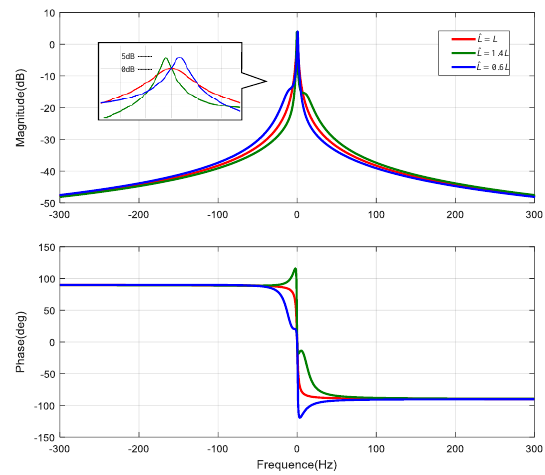
Figure 5. Complex vector FRF for variations in ˆ L of the inverter with a cross-coupling decoupling synchronous frame PI current controller, shown in the synchronous reference frame.